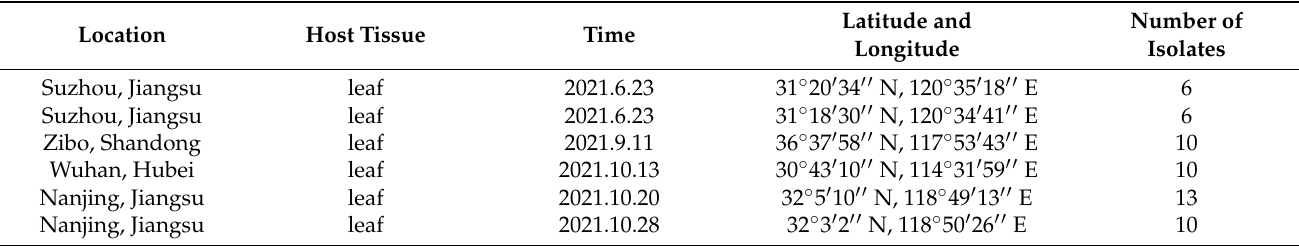
Table 1. The sample list of Colletotrichum isolates collected from Salix babylonica in